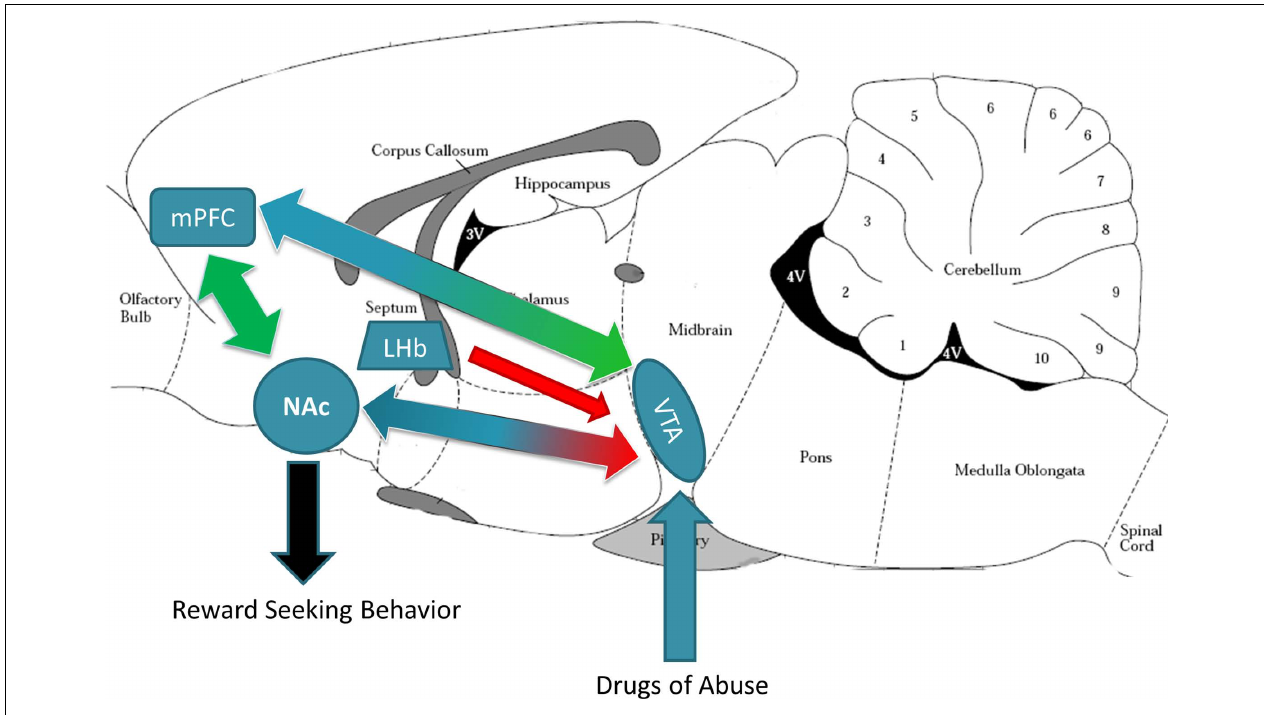
LHb) send GABAergic projections (red arrows) to theVTA, while the mPFC sends glutamatergic projections (green arrows) to theVTA.The mPFC and NAc have reciprocal glutamatergic projections. Activity changes in the NAc results in reward seeking or incentive behaviors (black arrow). Brain schematic adapted from Paxinos andWatson